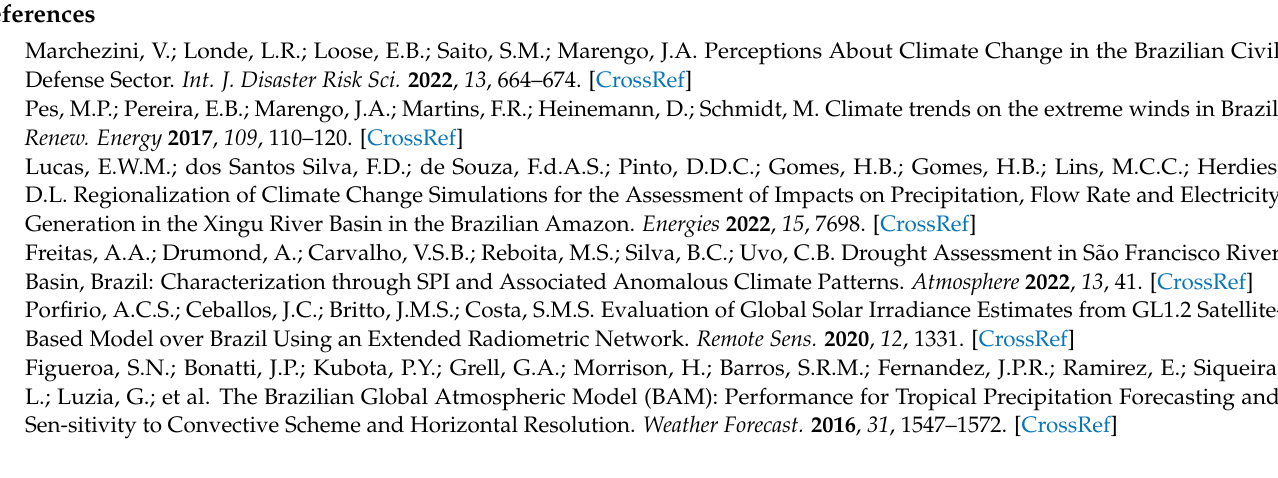
and the bottom panel is derived from the BAM-ZERO simulations. The left column shows BIAS on a daily scale, the middle column shows BIAS on a decennial scale, and the right column shows BIAS on a monthly scale; Figure S17. MAE of wind speed (m · s − 1 ). The upper panel is derived from the BAM-CLIM simulations, the middle panel is derived from the BAM-CTE simulations, and the bottom panel is derived from the BAM-ZERO simulations. The left column shows MAE on a daily scale, the middle column shows MAE on a decennial scale, and the right column shows MAE on a monthly scale; Figure S18. RMSE of wind speed (m · s − 1 ). The upper panel is derived from the BAM-CLIM simulations, the middle panel is derived from the BAM-CTE simulations, and the bottom panel is derived from the BAM-ZERO simulations. The left column shows RMSE on a daily scale, the middle column shows RMSE on a decennial scale, and the right column shows RMSE on a monthly scale; Figure S19. Correlation of wind speed. The upper panel is derived from the BAM-CLIM simulations, the middle panel is derived from the BAM-CTE simulations, and the bottom panel is derived from the BAM-ZERO simulations. The left column shows correlation on a daily scale, the middle column shows correlation on a decennial scale, and the right column shows correlation on a monthly scale; Figure S20. Wind speed CI. The upper panel is derived from the BAM-CLIM simulations, the middle panel is derived from the BAM-CTE simulations, and the bottom panel is derived from the BAM-ZERO simulations. The left column shows CI on a daily scale, the middle column shows CI on a decennial scale, and the right column shows CI on a monthly